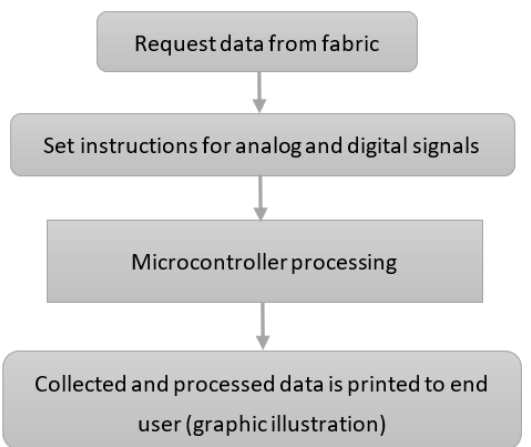
Figure 4. Flow diagram of the software processing the signals from the material.